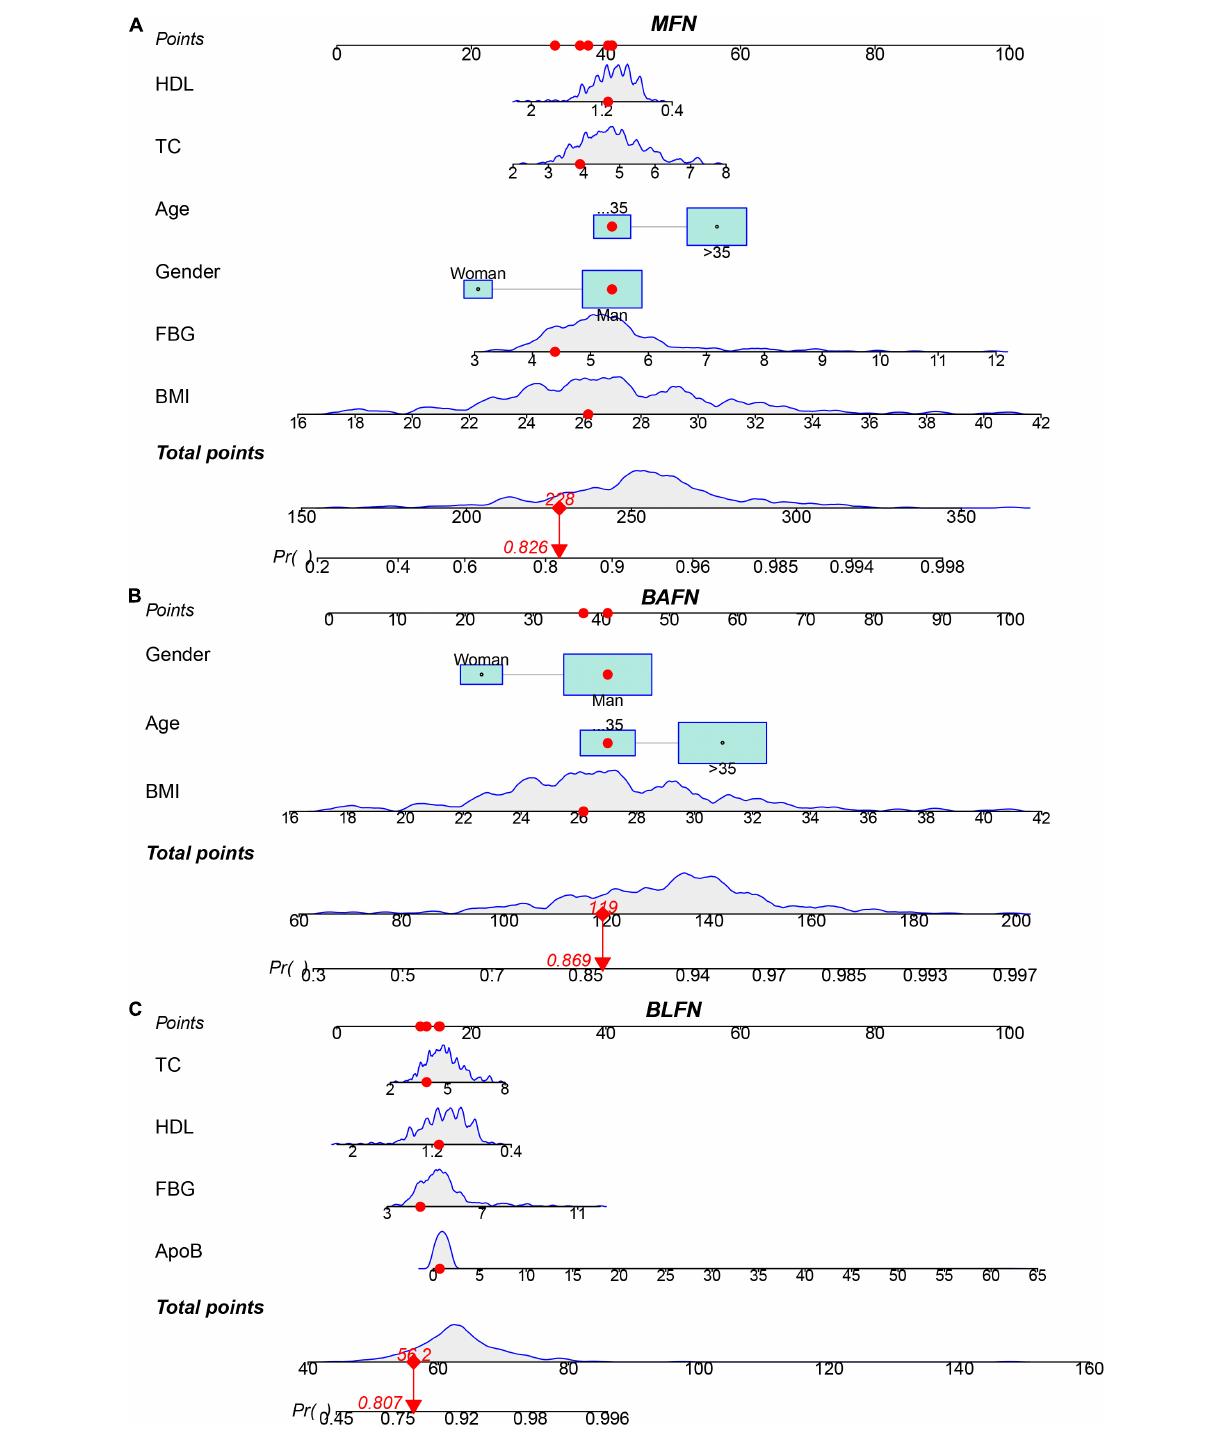
obstruction, apnea or hypopnea can all be caused by the increased physical weight of these tissues. Lung mechanics is also affected by increased body mass, reducing functional residual volume